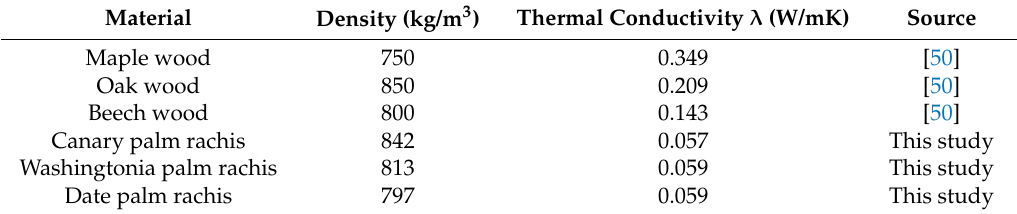
Table 6. Average thermal conductivity values of wood with similar densities as rachis particleboards.